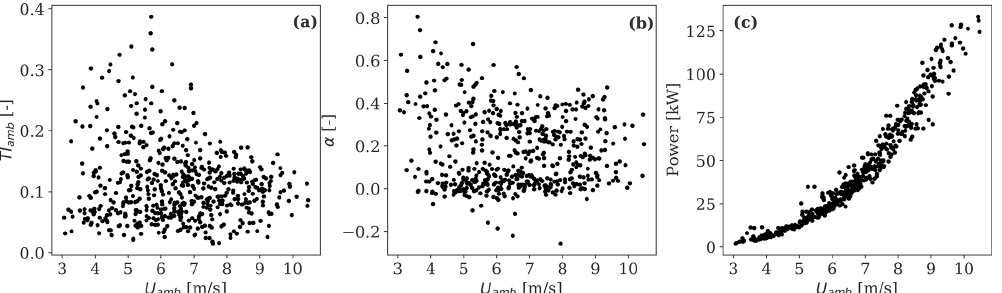
Figure 3. Inflow wind and operational conditions at the SWiFT site. (a) Hub-height turbulence intensity as a function of the hub-height mean wind speed based on the mast inflow measurements, (b) power-law shear exponent derived using observations from the 18 and 45m sonic measurements, and (c) power productions of WTGa1 recorded from SCADA. Each marker represents a 10min period.